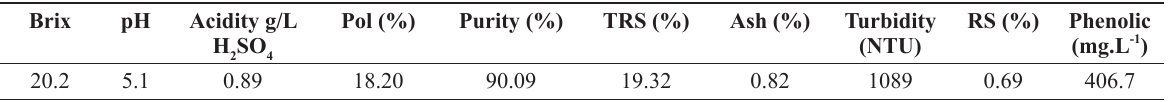
Average values obtained for Brix, pH, Acidity, Pol, Purity, TRS, Ash, Turbidity, RS and Phenolic Compounds of extracted juice. Jaboticabal-SP. 2015/2016 crop year.